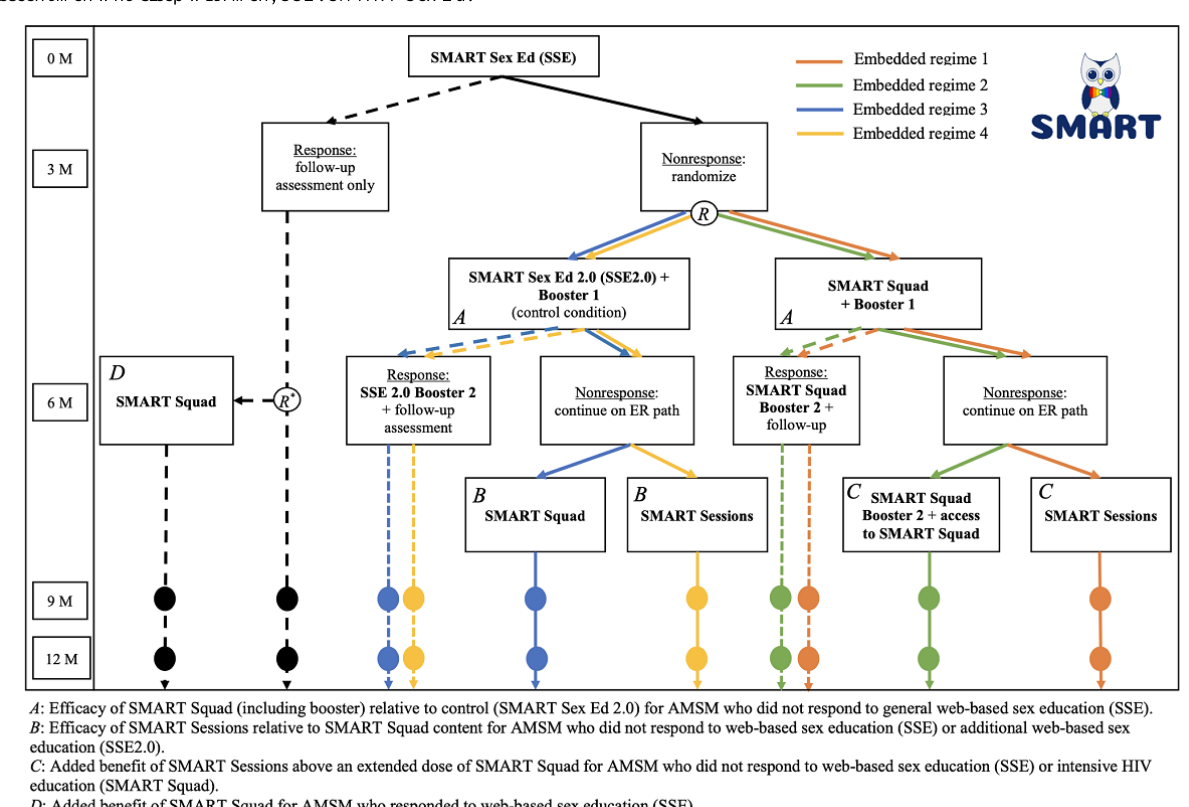
Figure 1. SMART participant intervention progression. Survey assessments are conducted at baseline (0 M), 3 months (3 M), 6 months (6 M), 9 months (9 M), and 12 months (12 M). An embedded regime is the path or sequence of specified interventions to which a participant may be randomized. The circled letter “R” refers to the point at which participants are randomized to an embedded regime, or in the case of responders to SSE (see R* ), either follow-up only or access to SMART Squad after the 6-month assessment. Dashed embedded regime paths represent responder pathways. AMSM: adolescent men who sleep with men; SSE: SMART Sex